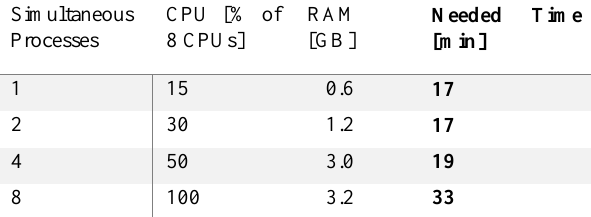
Table 3. Maximum workload of hardware usage for cloud solution per VM